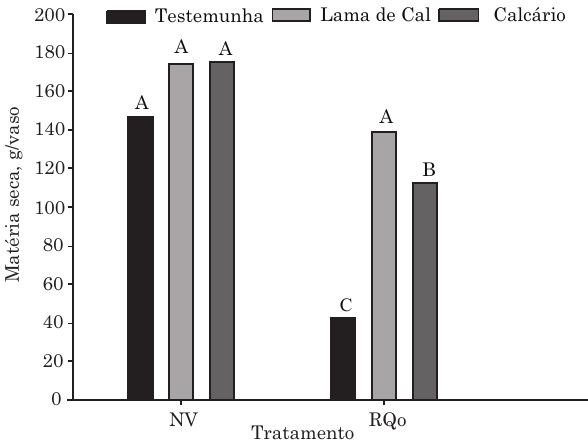
Figura 1. Produção de matéria seca da parte aérea de plantas de Eucalyptus saligna cultivadas em Nitossolo Vermelho eutroférrico (NV) e Neossolo Quartzarênico órtico (RQo), em razão da aplicação de calcário dolomítico e lama de cal. Médias seguidas da mesma letra, no mesmo solo, não diferem significativamente pelo teste de Tukey a 5